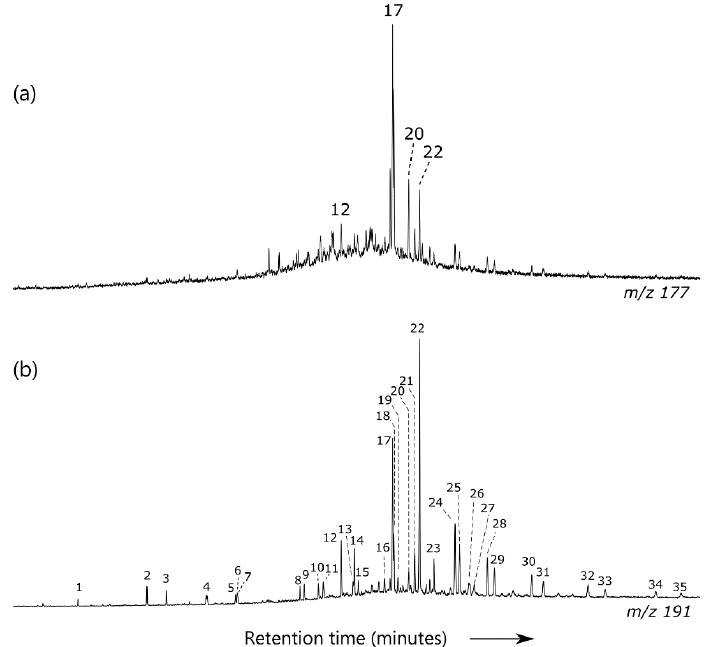
Figure 4. ( a ) and ( b ), respectively, m/z 177 and m/z 191 ion fragmentograms for the saturated fraction showing the triterpane distribution for a representative oil sample.